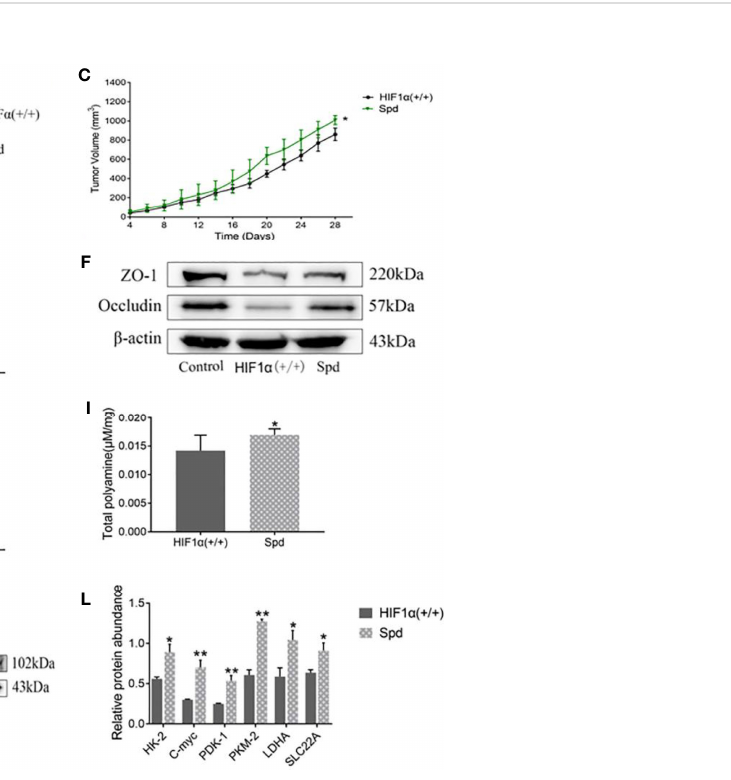
FIGURE 6 Effects of exogenous polyamine supplementation on tumor growth, intestinal mucosal permeability, and polyamines in tumor-bearing mice. (A) Body weight of tumor-bearing mice after exogenous polyamine supplementation. (B) Tumor tissue from tumor-bearing mice after exogenous polyamine supplementation. (C) Changes in tumor volume in tumor-bearing mice after exogenous polyamine supplementation. (D) Tumor mass in tumor-bearing mice after exogenous polyamine supplementation. (E) D-lactic acid value of tumor-bearing mice after supplementation with exogenous polyamines. (F) Expression of ZO-1 and occludin proteins in tumor-bearing mice after exogenous polyamine supplementation. (G) Western blot quantitative data of (F) . HIF1 a (+/+) group, * P < 0.05, *** P < 0.001 vs . control group; Spd group, # P < 0.05, ## P < 0.01 vs . HIF1 a (+/+) group. (H) Contents of polyamines in the intestinal mucosa of tumor-bearing mice after supplementation with exogenous polyamines. HIF1a (+/+) group, ***P < 0.001 vs. control group; Spd group, ##P < 0.01 vs. HIF1a (+/+) group. (I) Contents of polyamines in tumor tissues of tumor-bearing mice after exogenous polyamine supplementation. (J) The amount of glycolysis-related proteins in tumor-bearing mice after exogenous polyamine supplementation. (K) The amount of SLC22A protein in tumor- bearing mice after supplementation with exogenous polyamines. (L) Quantitative data of (J) and (K) . Spd group * P <0.05, ** P <0.01 vs . HIF1 a (+/+)